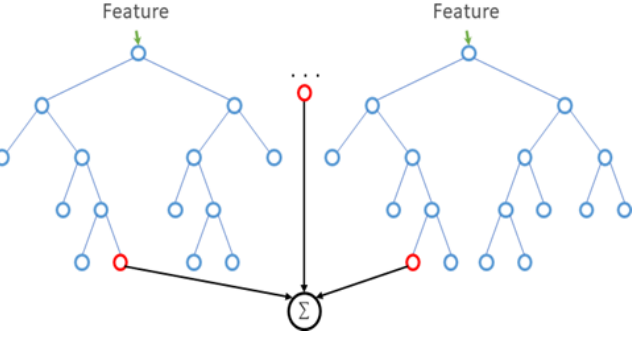
Figure 4. Illustration of a typical RF